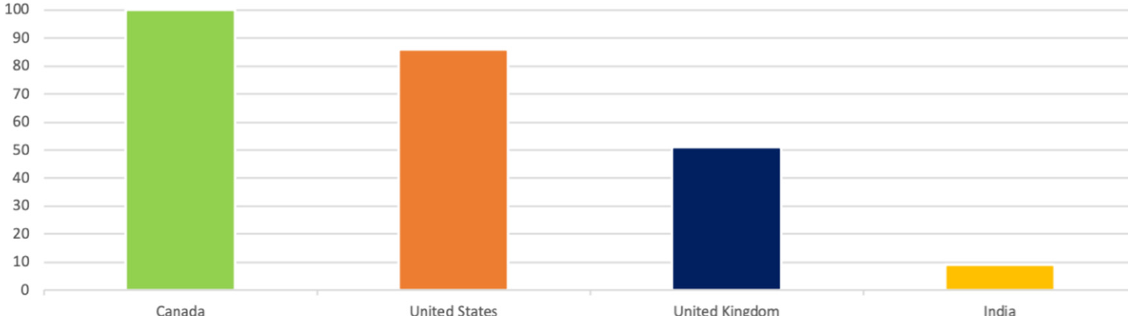
Figure 6. Google search for “NFT Sound” by country.